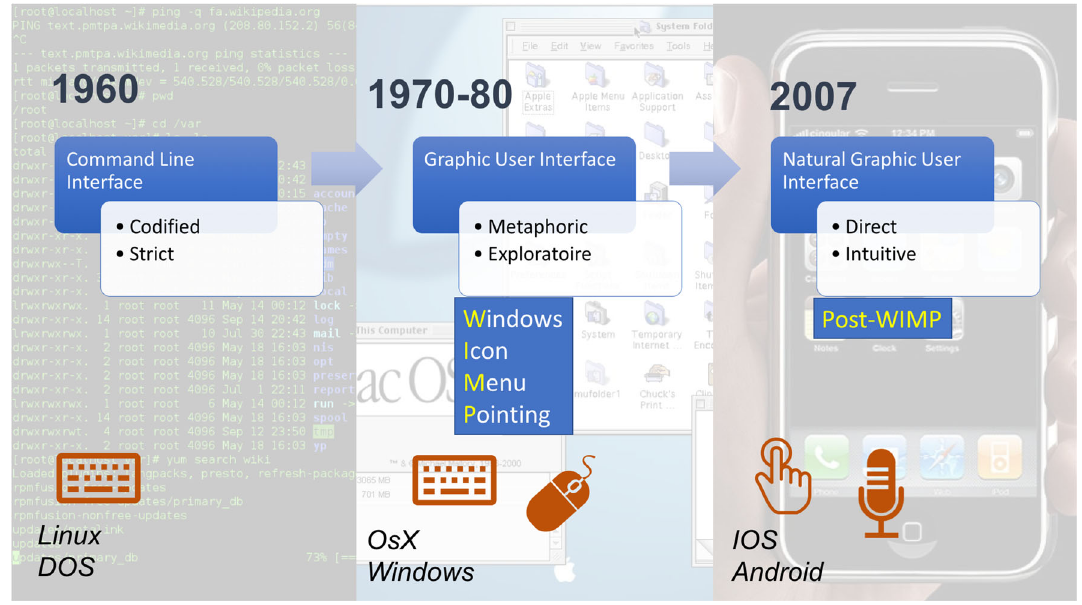
Fig. 3 History of common computer user interfaces. The most common user interface (UI) is the graphical UI (GUI) used by operating systems (OS) of popular personal computers in the 1980s. It is designed with a